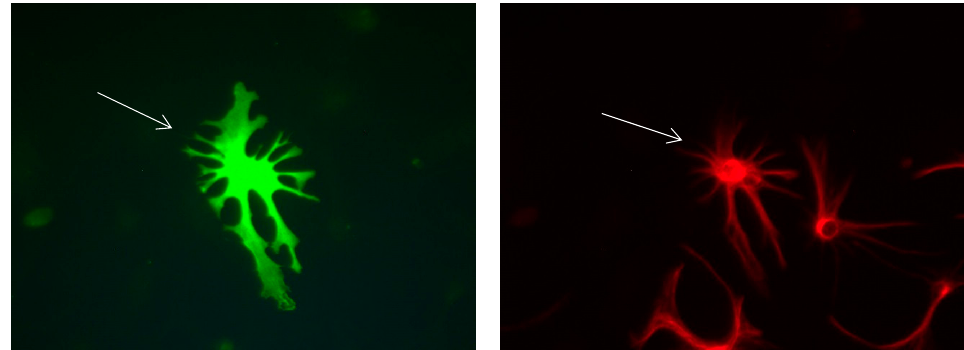
Figure 8. Cultures in a serum-free medium, 5 days (6 days after the passage): Immunofluorescence with anti-GFAP (glial fibrillary acidic protein) (red, secondary antibody: donkey anti-goat IgG Alexa Fluor 594), and with anti-Calbindin D28k (polyclonal antibody from the company SWANT) (green, secondary antibody: donkey anti-rabbit IgG Alexa Fluor 488). Epifluorescence microscopy. One giant Calbindin D28k positive and GFAP-positive astrocyte (long arrows) with processes.